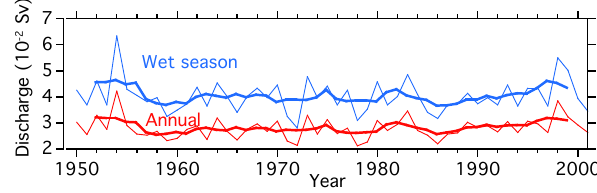
Figure 2. Annual (red) and wet season (May–October) (blue) dis- charges of the Changjiang at Datong station from 1950 to 2000. Bold lines represent 5-year running mean.